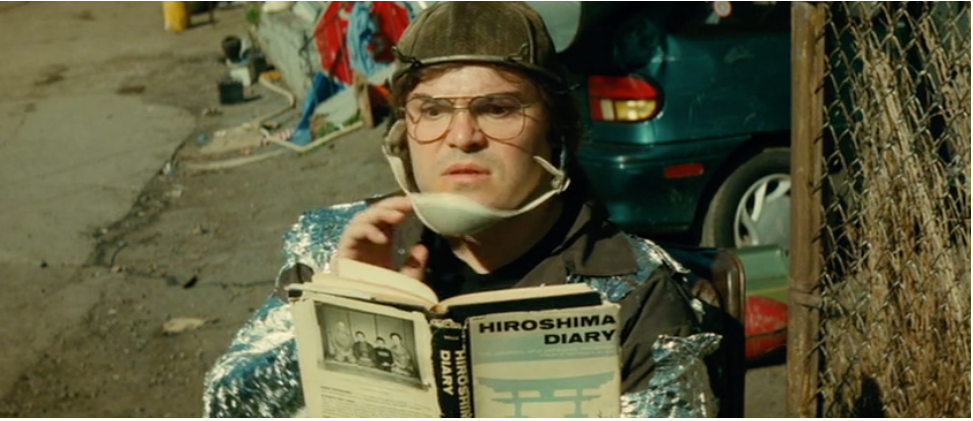
Figure 1. Armoured Jerry (Jack Black) “on set” and in costume at the junkyard.